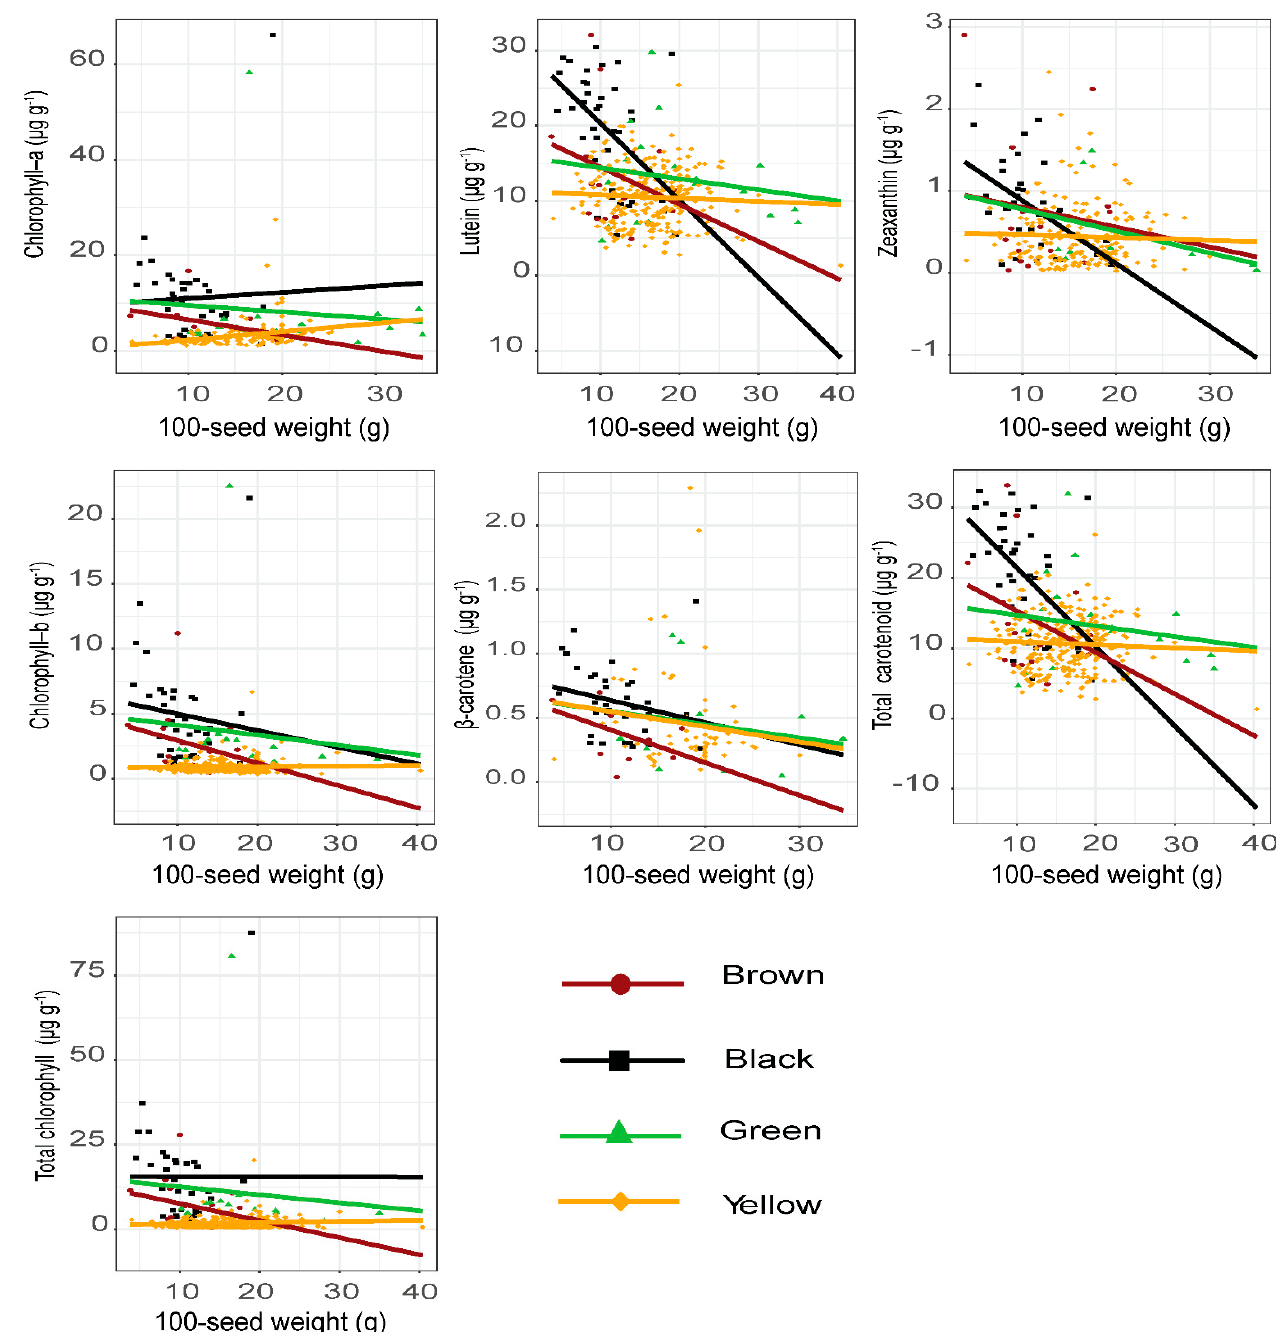
Figure 5. Linear regression analyses between the lipophilic pigment components and 100-seed weight in brown ( n = 18), black ( n = 41), green ( n = 18) and yellow ( n = 331) soybean germplasm